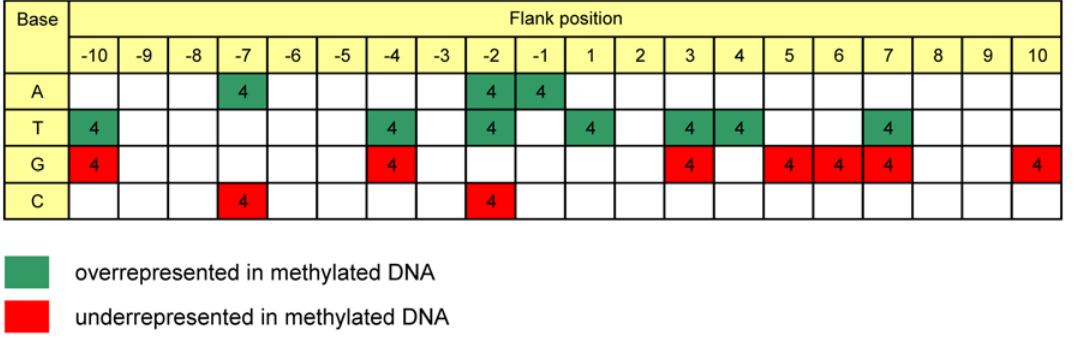
Figure 5. Over- and under-representation of bases in the flanks of methylated CpG sites using different threshold of DNA methylation ( $ 90%, $ 80%, $ 70%, or $ 60%). The numbers indicate how often a significant p -value was observed in the four data sets. Here only data are shown which were significantly biased with all four tested thresholds. Green and red colors indicate that the base is significantly over- or under-represented, respectively, in the flanks of methylated CpG sites. As an example, the p -values observed for overrepresentation of flanking nucleotides at methylation levels $ 90% are shown in Text S3.